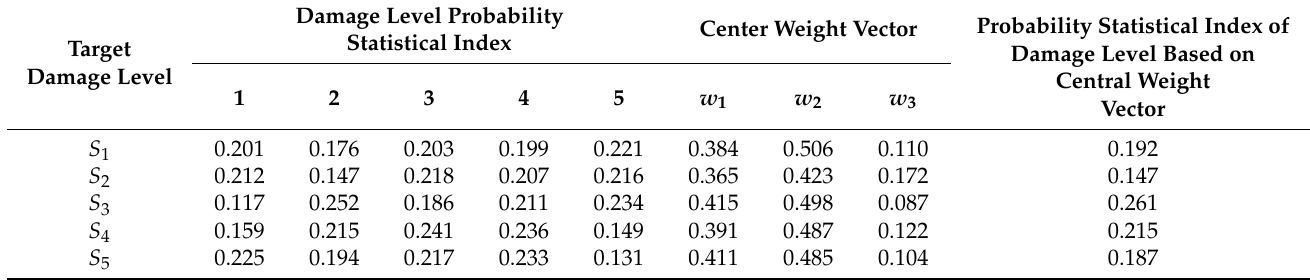
Table 3. The calculation results of target damage level when w 1 = 0.4, w 2 = 0.5, w 3 =